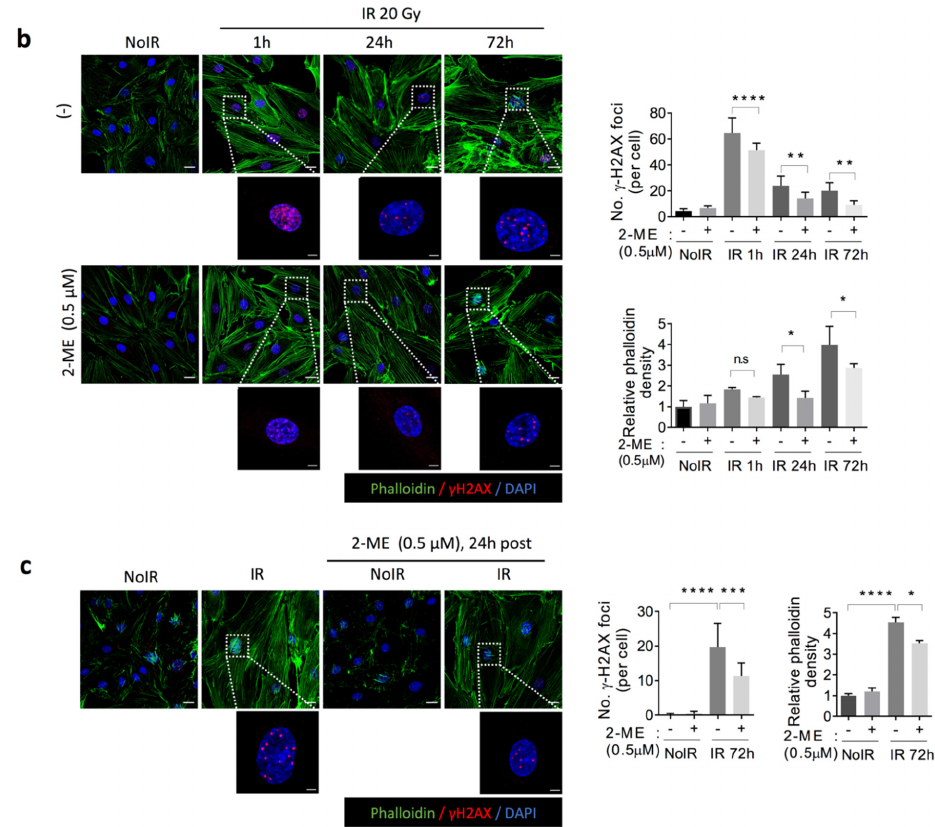
Figure 4. Knockdown of HIF-1 α inhibits radiation-induced DNA damage and fibrotic change in HDMECs. ( a ) Immunofluorescence staining of phalloidin and γ -H2AX in HDMECs transfected with HIF-1 α siRNA and control siRNA. Transfected HDMECs were irradiated with 20 Gy and harvested at 1 h, 24 h, and 72 h. Scale bar = 20 μ m; scale bar of the cropped images = 5 μ m. Bar graphs indicate the number of γ -H2AX foci per cell and the relative density of phalloidin ( n = 4 independent exper- iments). The average number of foci/cell was determined from five fields (magnification, 200×). For quantification of phalloidin density, error bars represent mean ± SD (one-way ANOVA for multiple comparisons). For quantification of the number of γ -H2AX foci, error bars represent mean ± SD (one-way ANOVA for multiple comparisons). ( b ) Immunofluorescence staining of phalloidin and γ -H2AX in HDMECs treated with 2-ME (0.5 μ M) before being irradiated with 20 Gy. (-) represents the treatment of DMSO. The cells were harvested at 1 h, 24 h, and 72 h. Scale bar = 20 μ m; scale bar of the cropped images = 5 μ m. Bar graphs indicate the number of γ -H2AX foci per cell and the phalloidin density ( n = 4 independent experiments). The average number of foci/cell was deter- mined from five fields (magnification, 200×). For quantification of phalloidin density, error bars rep- resent mean ± SD (one-way ANOVA for multiple comparisons). For quantification of the number of γ -H2AX foci, error bars represent mean ± SD (one-way ANOVA for multiple comparisons). ( c ) Immunofluorescence staining of phalloidin and γ -H2AX in HDMECs treated with 2-ME (0.5 μ M) after 24 h irradiated with 20 Gy. The cells were harvested at 72 h. Scale bar = 20 μ m; scale bar of the cropped images = 5 μ m. Bar graphs indicate the number of γ -H2AX foci per cell and the relative density of phalloidin ( n = 4 independent experiments). The average number of foci/cell was deter- mined from five fields (magnification, 200×). For quantification of phalloidin density, error bars rep- resent mean ± SD (one-way ANOVA for multiple comparisons). For quantification of the number of γ -H2AX foci, error bars represent mean ± SD (one-way ANOVA for multiple comparisons). * p < 0.05, ** p < 0.01, *** p < 0.001, and **** p < 0.0001.